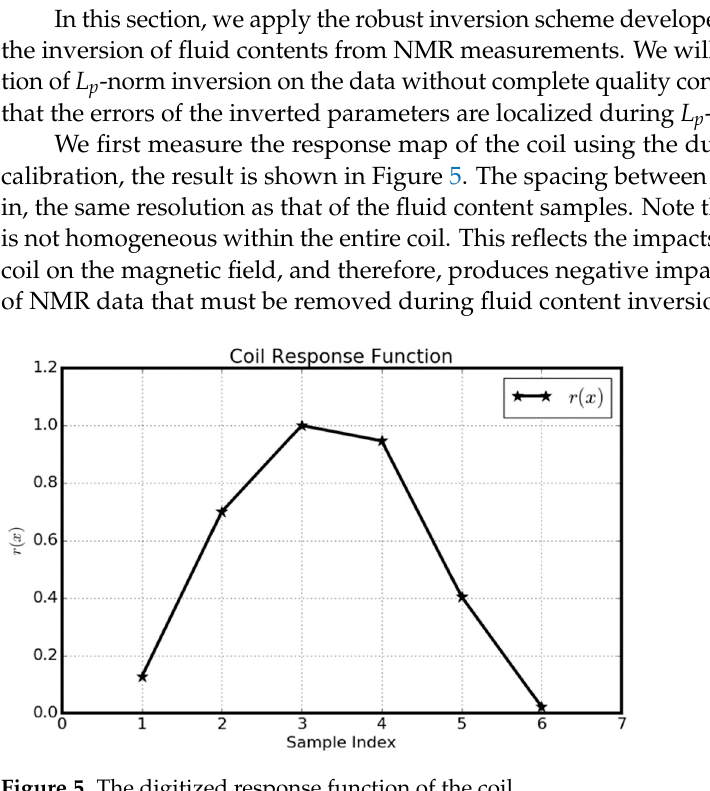
Figure 6. Workflow of NMR inversion. Figure 7 shows the inversion of three cores. We plot the inverted results of the fluid content and also insert the core photos. The color of the core represents the laminated distribution of kerogen along the core, a key factor for the estimation of the oil and gas reserves. The darker color indicates higher kerogen content in the core. In the pre- processing step, considering the ending effects, the first two and very last NMR signals are removed for all the core measurements. We will show the inverted results without pre-processing later on.